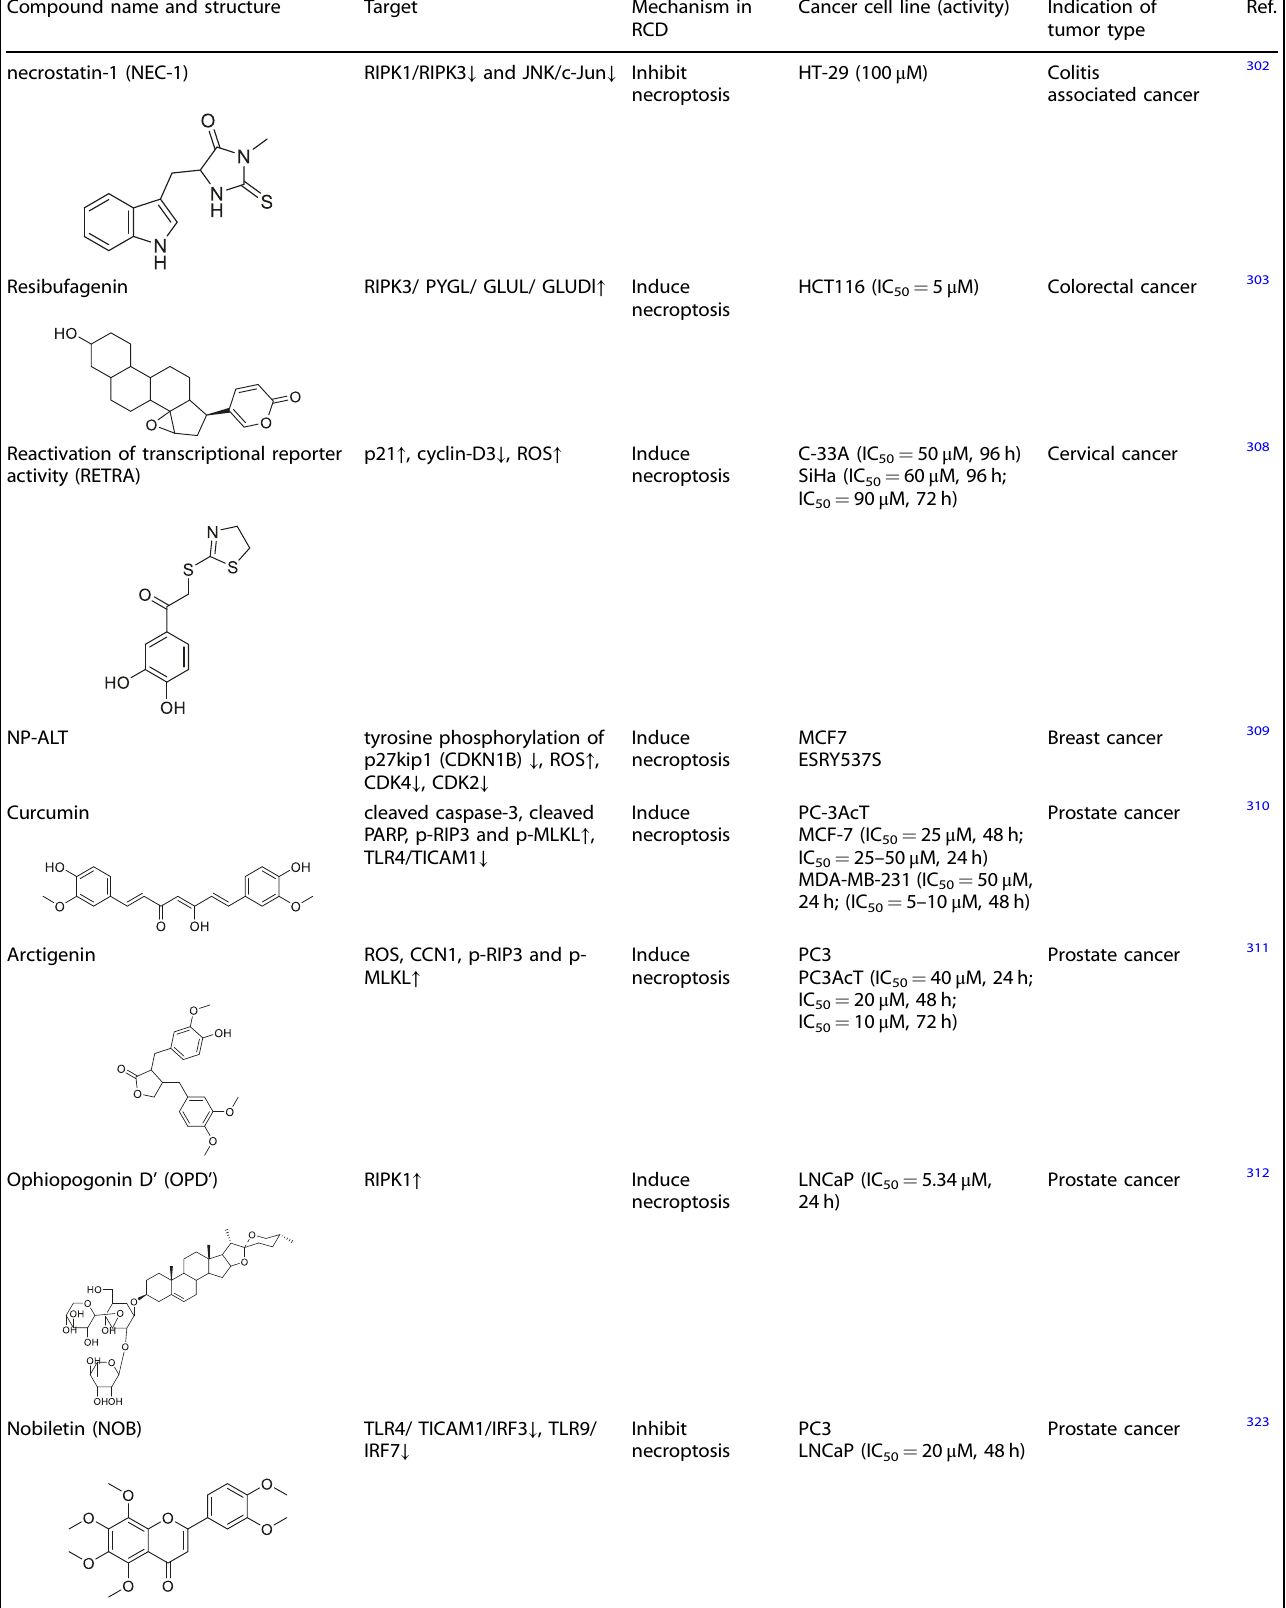
Table 10. Compounds targeting RIPK1/ RIPK3/MLKL, TLR4/TICAM1, ZBP1 and other targets of necroptosis in